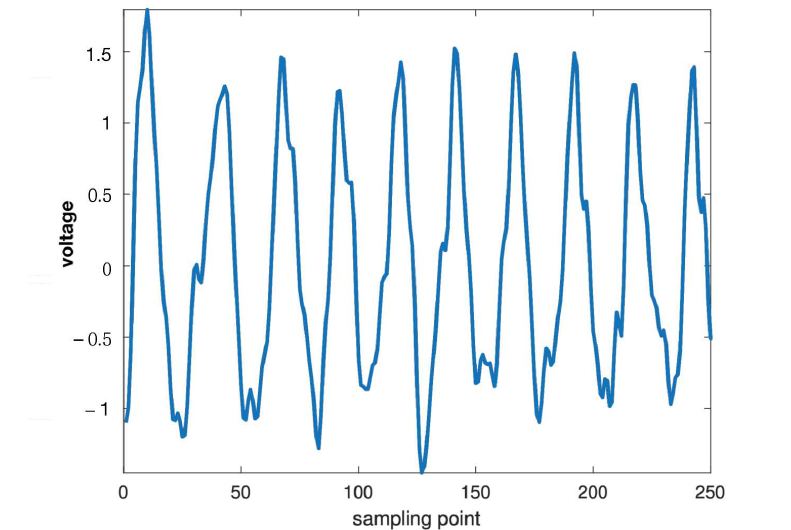
Figure 5. An example of a refined SSVEP signal after denoising, spatial filtering, and trial averaging (10